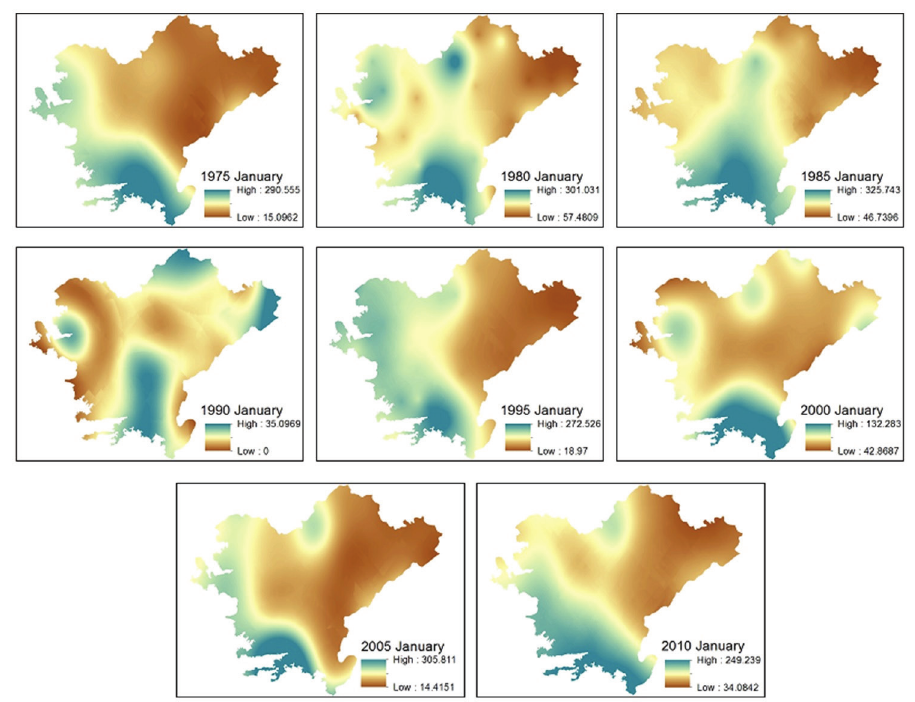
Figure 4 - The Ordinary Kriging interpolation results of the precipitation data for the month of January (For the years of 1975, 1980, 1985, 1990, 1995, 2000, 2005, and